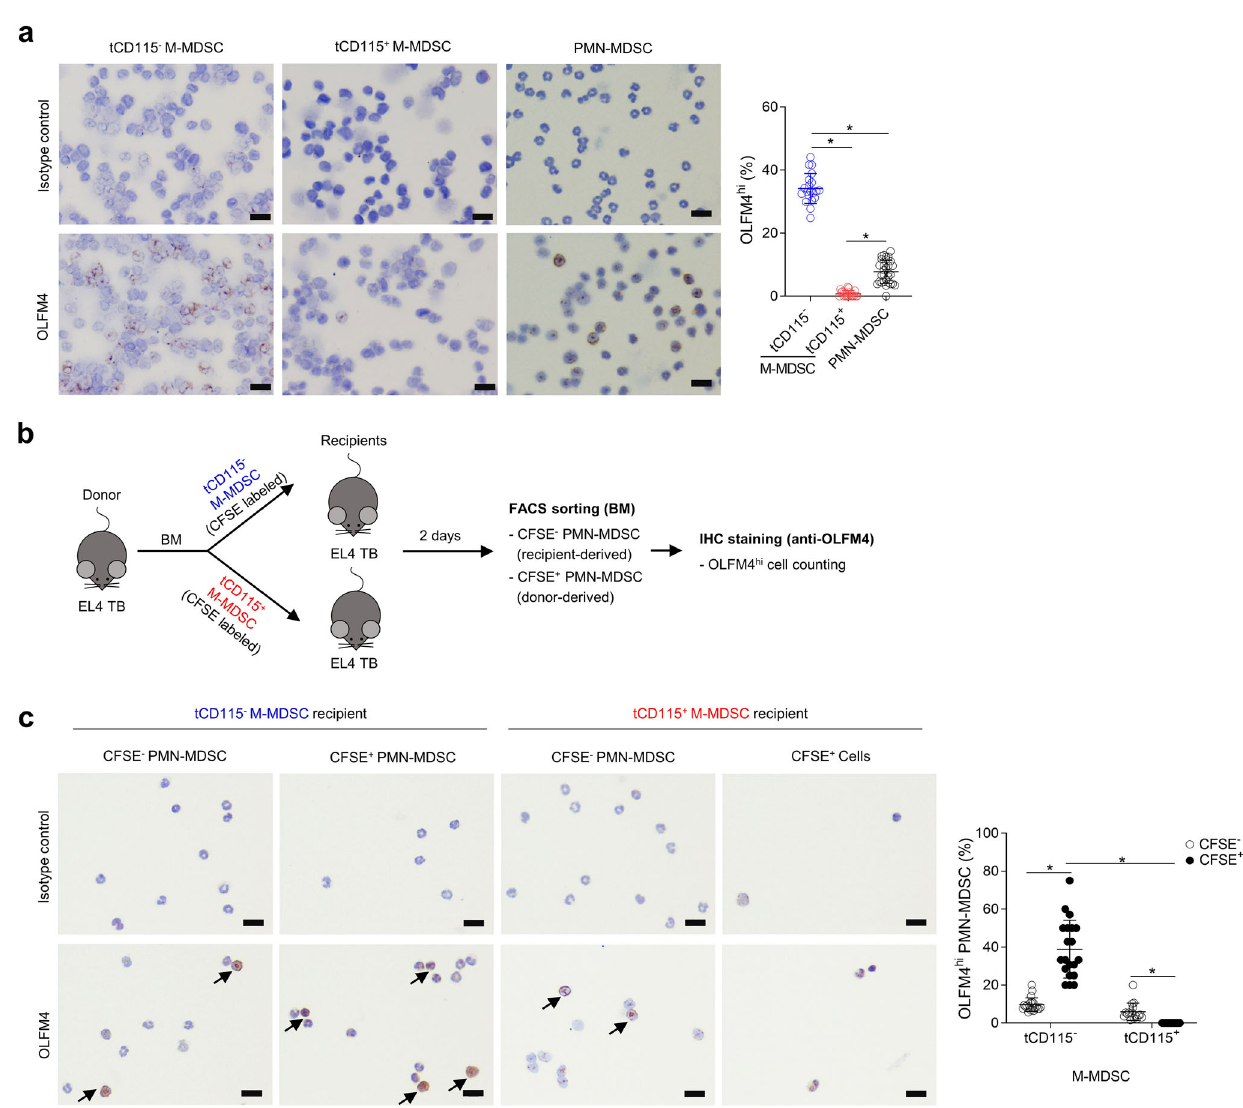
Fig. 5 CD115 − M-MDSCs express OLFM4 and differentiate into OLFM4 hi PMN-MDSCs. a BM cells from three EL4 TB mice were pooled and CD115 − M- MDSCs, CD115 + M-MDSCs, and PMN-MDSCs were sorted. Cells were stained for OLFM4 and OLFM4 hi cells were counted from ten random fi elds. Data pooled from two to three separate experiments. Representative IHC analysis of OLFM4 expression and ratios of OLFM4 hi cells. The letter “ t ” indicates that cells were isolated from TB mice. b Schematic diagram of experimental design. CD115 − and CD115 + M-MDSCs were sorted from donor EL4 TB mice and labeled with CFSE, then CD115 − and CD115 + M-MDSCs were injected into separate recipient EL4 TB mice ( n = 3 per group). Two days later, BM cells from three recipient mice were pooled and OLFM4 expression in sorted PMN-MDSCs (CD11b + Ly6G + Ly6C lo ) were analyzed by IHC to determine the ratio of OLFM4 hi PMN-MDSC. c OLFM4 hi cells were counted from seven to ten random fi elds. IHC analysis of OLFM4 expression and ratios of OLFM4 hi cells. Data pooled from two separate experiments. Scale bars = 20 μ m. One-way ANOVA with correction for multiple comparisons test was used: * p < 0.05. Data are mean ±